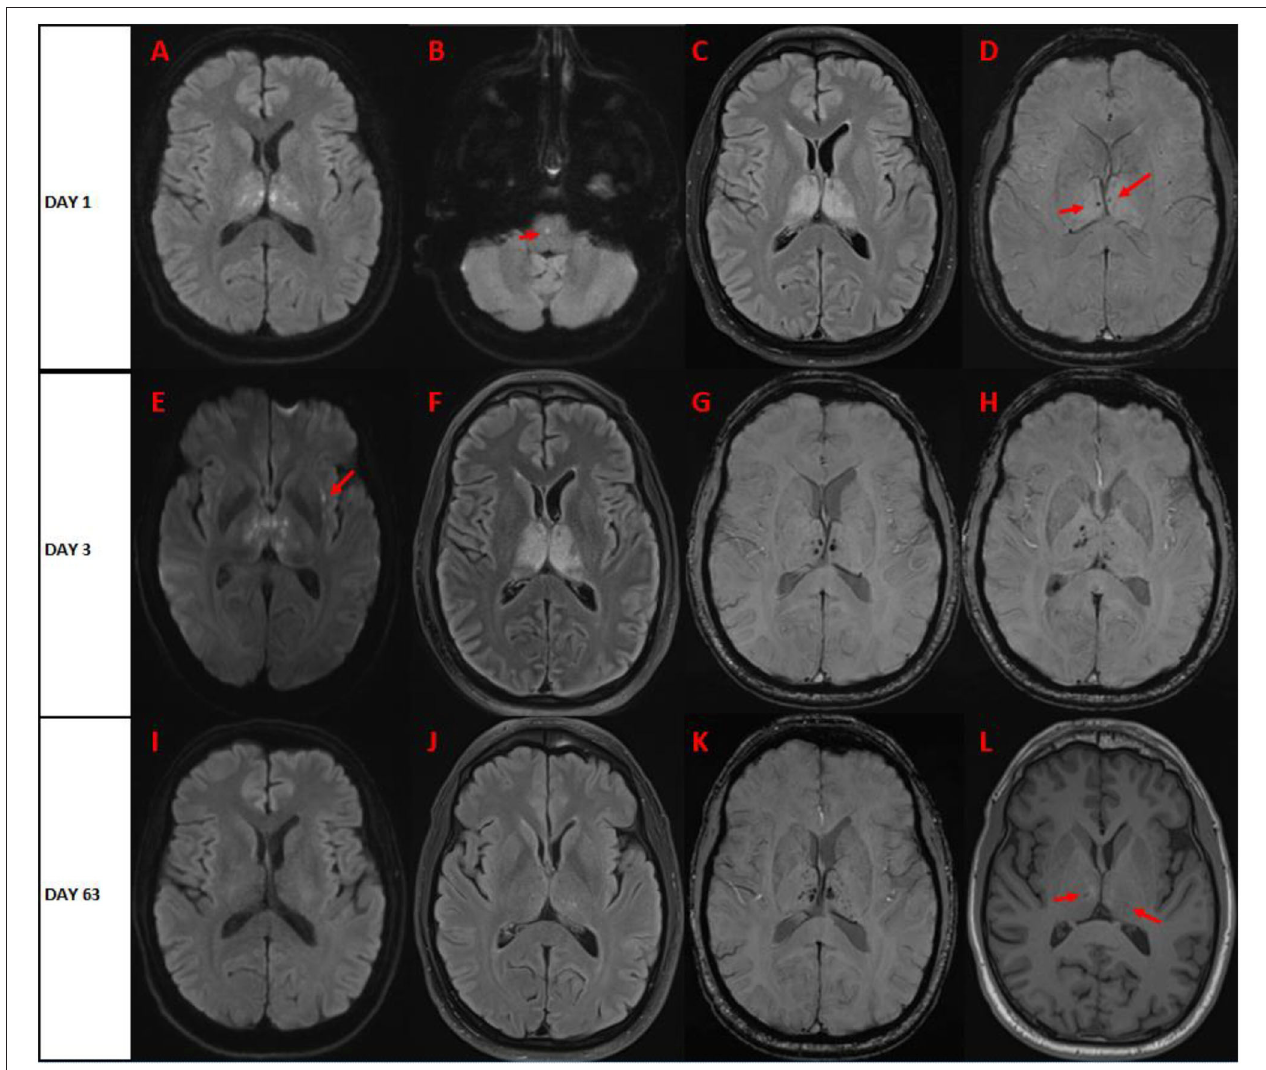
FIGURE 1 | Brain magnetic resonance on (A–D) day 1 (E–H) day 3, and (I-L) day 63 after symptom onset. (A) Diffusion-weighted imaging (DWI) shows bilateral symmetric punctiform restrictive lesions in bilateral thalami. (B) DWI shows single punctiform restrictive pontine lesion. (C) FLAIR imaging shows bilateral hyperintense lesions of the thalami, with no significant mass effect. (D) Susceptibility-weighted imaging (SWI) shows two punctiform hypointense lesions in bilateral thalami. On day 3, (E) DWI shows increase of the restrictive lesions of bilateral thalami, and new peri-insular restrictive lesions (arrow). (F) FLAIR imaging shows relative stability of bilateral hyperintensities involving thalami. (G,H) SWI shows increase hypointense microhemorrhagic lesions of bilateral thalami. On day 63, (I) DWI sequence shows resolution of restrictive lesions. (J) FLAIR imaging sequence reveals near resolution of thalamic hyperintensities. (K) SWI indicates persistence of hypointense microhemorrhagic bilthalamic lesions. (L) T1-weighted imaging shows subtle hypointense lesions in bilateral thalami